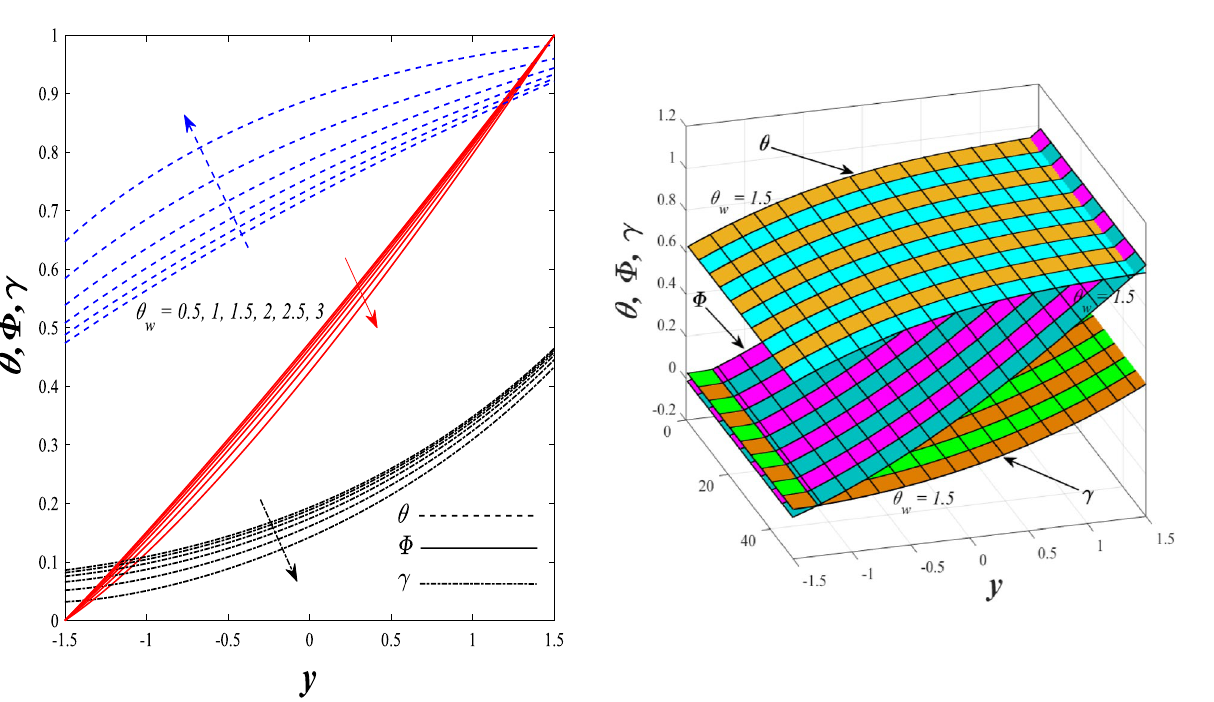
Figure 10. Effect of temperature ratio parameter θ w on the distributions of both temperature, solutal concentration and nanoparticles volume fraction 2D and